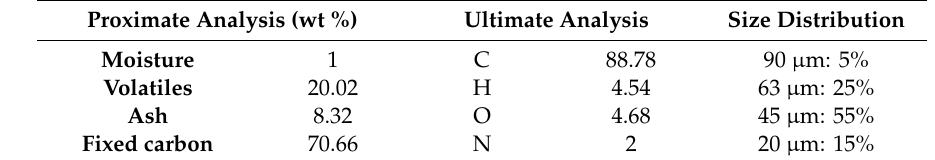
Table 3. Properties of coal [23].